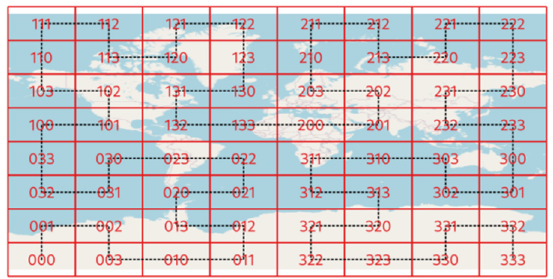
Figure 4. Basic global Hilbert grids.